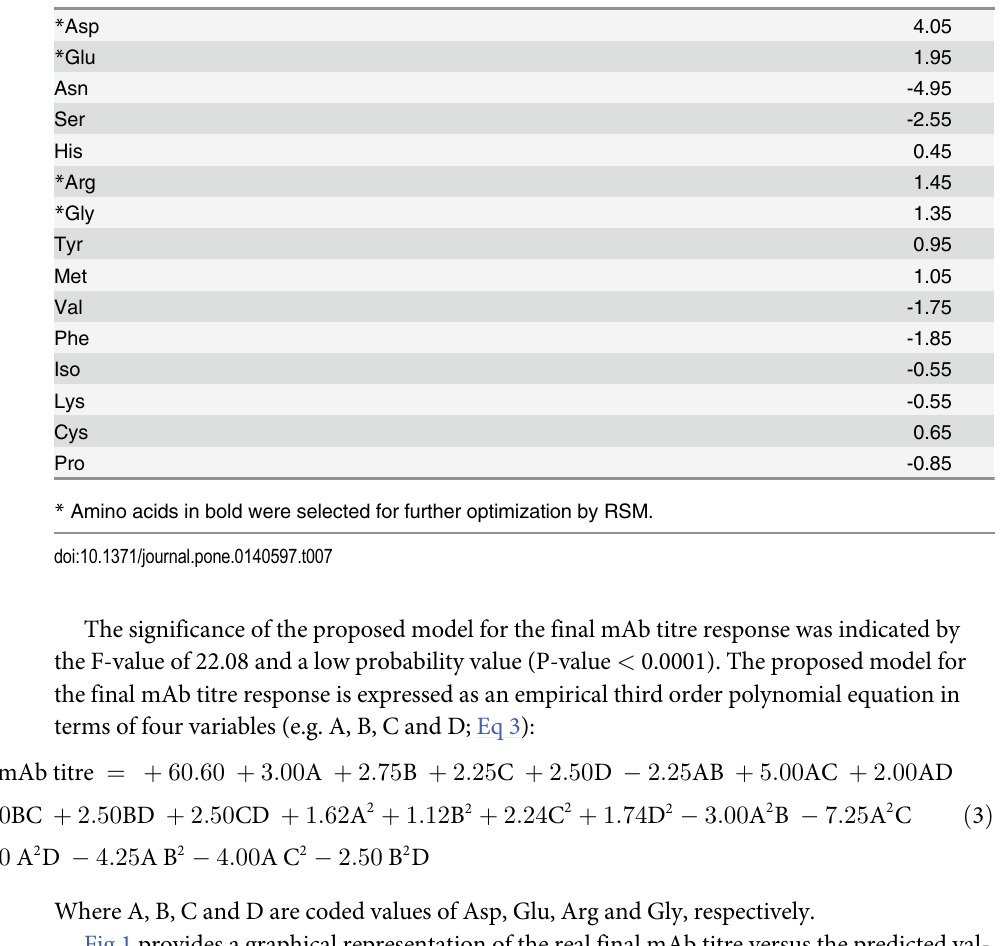
Table 7. The actual impacts of each significant amino acid on the final mAb titre, the actual impacts are the impacts of different amino acids on the final mAb titre and as it was expressed in Eq 1, these are the coefficients of related variables.